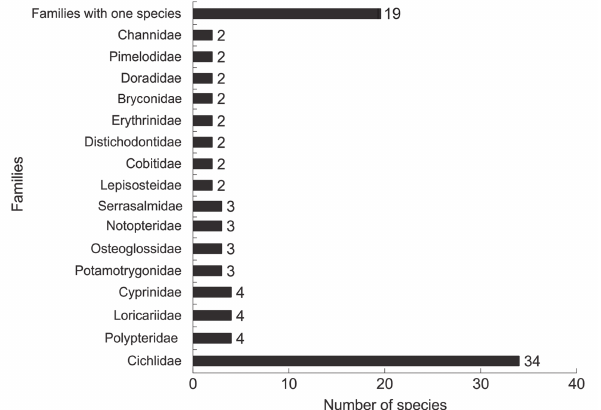
Fig. 2. Number of species of non-native large